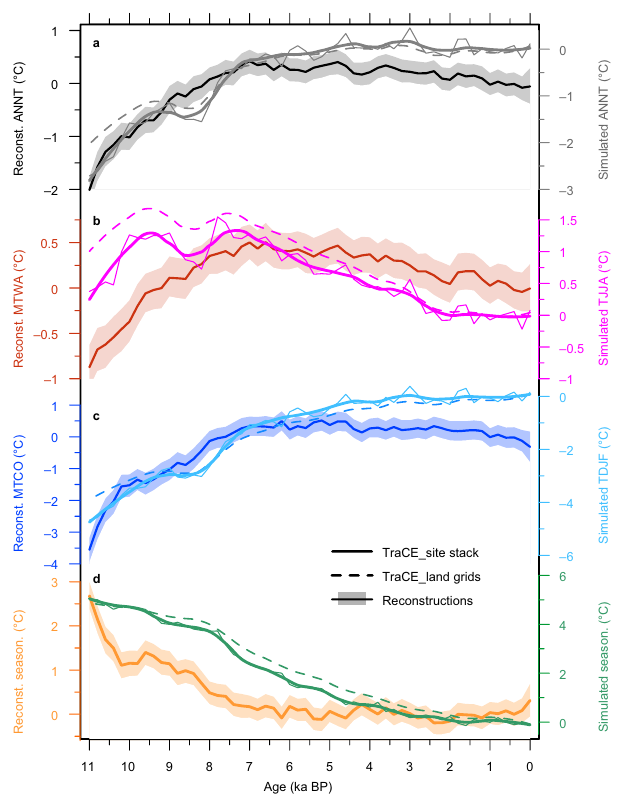
Fig. 3 | Model – data comparison of Holocene temperature evolution over the Northern Hemisphere (NH) landmass. Pollen-based and CCSM3-simulated chan- gesof( a )annual,( b )summer,and( c )wintertemperatures,andof( d )temperature seasonality (summer and winter temperature contrast). Shading indicates 95% uncertainty bands of reconstructions. Simulation results extracted from the same geographical locations as the pollen records are shown by solid lines (thin) with locally-weighted regression smoothing (LOESS;solidthicklines).We also showthe LOESS-smoothed simulation results from all NH land grids (dashed lines). The simulation results at pollen sites and all land grids show similar trends, indicating our records can well represent the NH